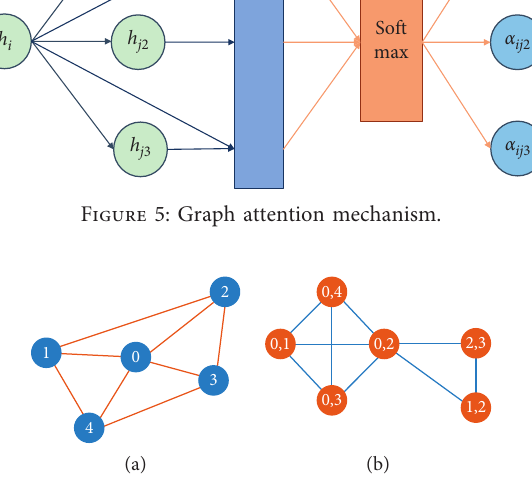
Figure 6: Primal graph (a) and dual graph